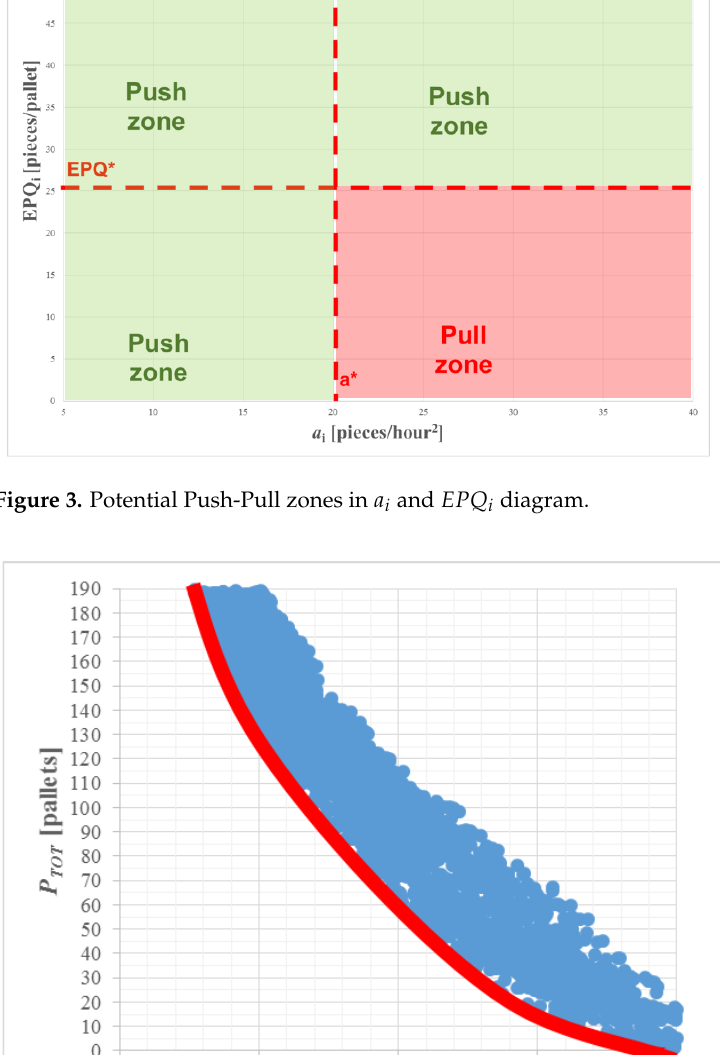
Figure 3. Potential Push-Pull zones in 𝑎 𝑖 and 𝐸𝑃𝑄 𝑖 diagram.